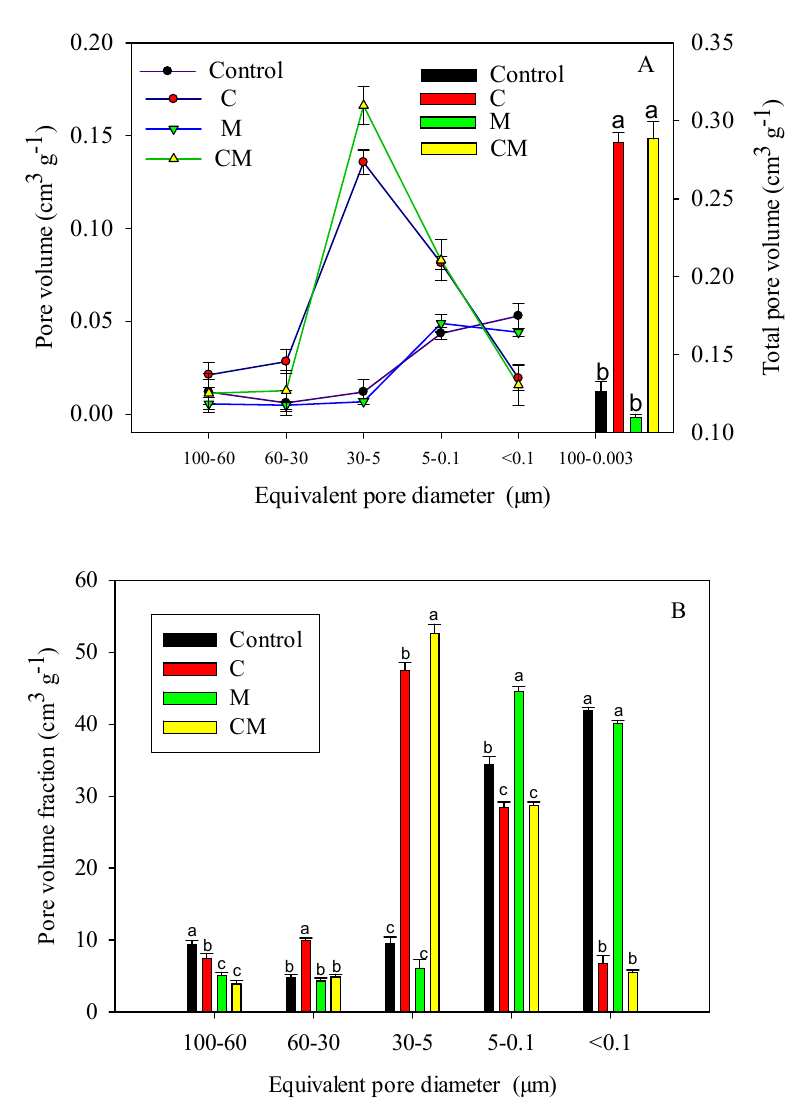
Figure 3. Determination of soil pore volume distribution through mercury intrusion (MIP) using the pore classification method of Cameron and Buchan [33,34]. ( A , B ) represent the pore volume and total pore volume at different treatment equivalent pore sizes and pore volume fraction, respectively. Values followed by different letters within horizontal row are significantly different ( p < 0.05).